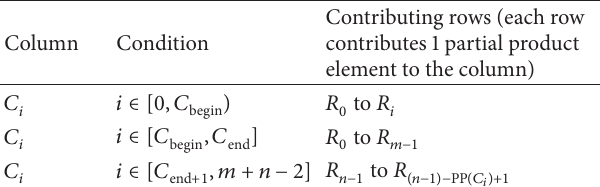
Table 6: Contributing rows for 𝑚 > 𝑛 . Contributing rows (each row Column